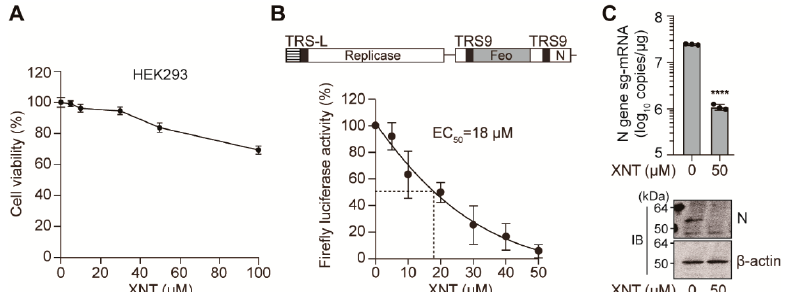
Figure 3. XNT inhibits SCoV1 replication. ( A ) Cytotoxicity of XNT in HEK293 cells, measured by MTS assay 24 h after treatment with increasing concentrations of XNT. ( B , C ) Inhibition of SCoV1 subgenomic replicon replication by XNT. HEK293 cells, co-transfected with pSARS-REP-Feo, a BAC- based SCoV1 subgenomic replicon-expressing plasmid along with pRL-TK used for transfection efficiency normalization. Six hours later, cells were treated with increasing concentrations of XNT for 24 h. Shown are the normalized luciferase activities relative to mock (0.1% DMSO vehicle)-treated cells ( B ). SCoV1 N-gene mRNA and N protein levels, determined by RT-qPCR and immunoblotting analysis ( C ). Feo, a Fluc gene fused to a neomycin phosphotransferase gene. TRS9, transcription-